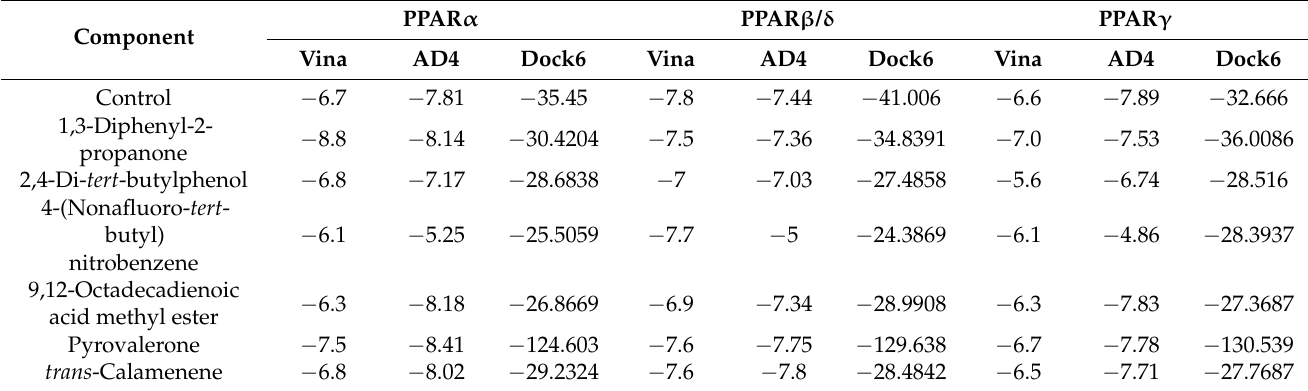
Table 2. In silico docking simulation of active volatile components of fermented soybean CGJ with PPARs. Component